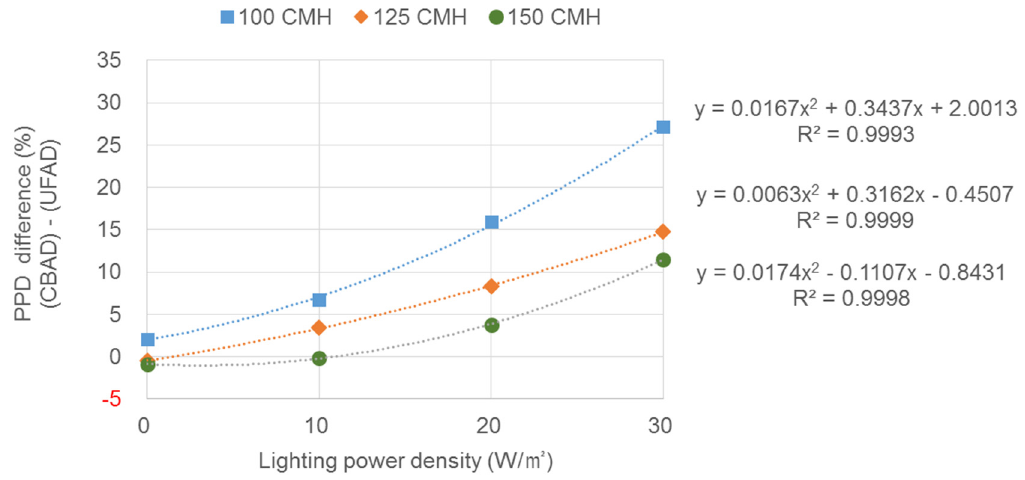
Figure 30. Difference in PPD between UFAD and CBAD